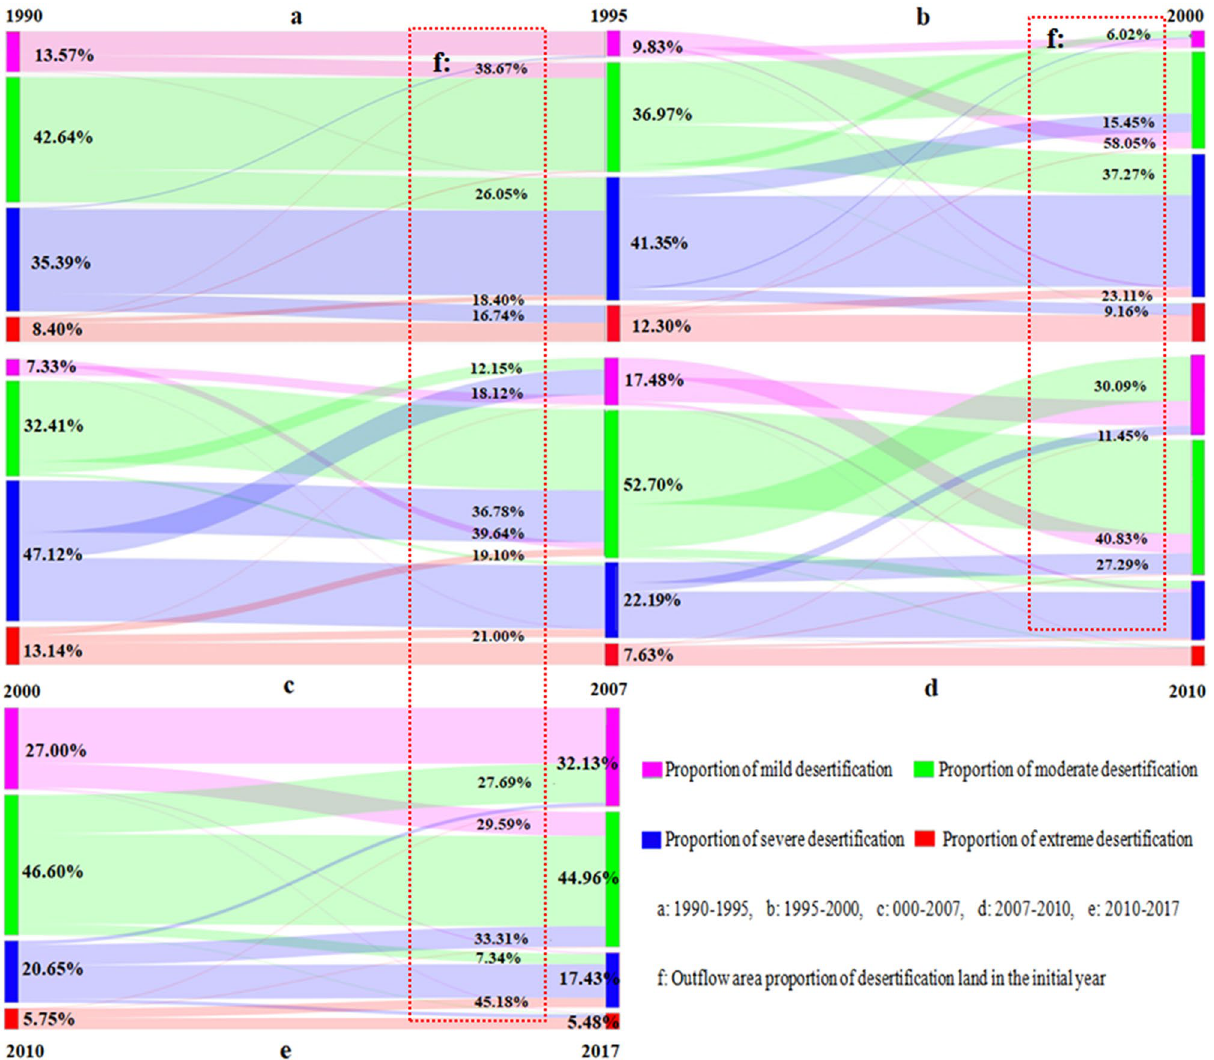
Figure 3. Changes in desertification land area transfer in the study area during: ( a ) 1990–1995, ( b ) 1995–2000, ( c ) 2000–2007, ( d ) 2007–2010, ( e ) 2010–2017, ( f ) the proportion and direction of desertification area outflow in the initial